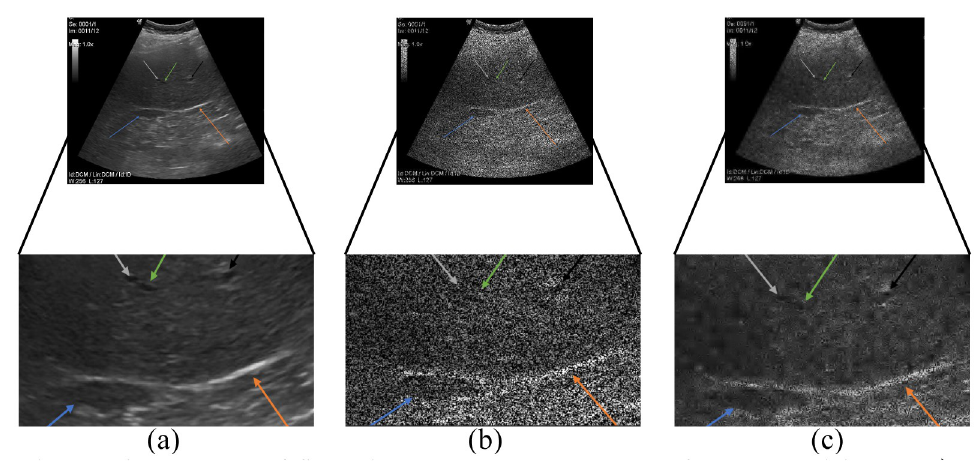
Fig 13. A example of filtration result by db2 , level of decomposition 4. a) native image, b) noisy image (speckle noise ( μ = 0, σ 2 = 1) and c) filtered MSK image.